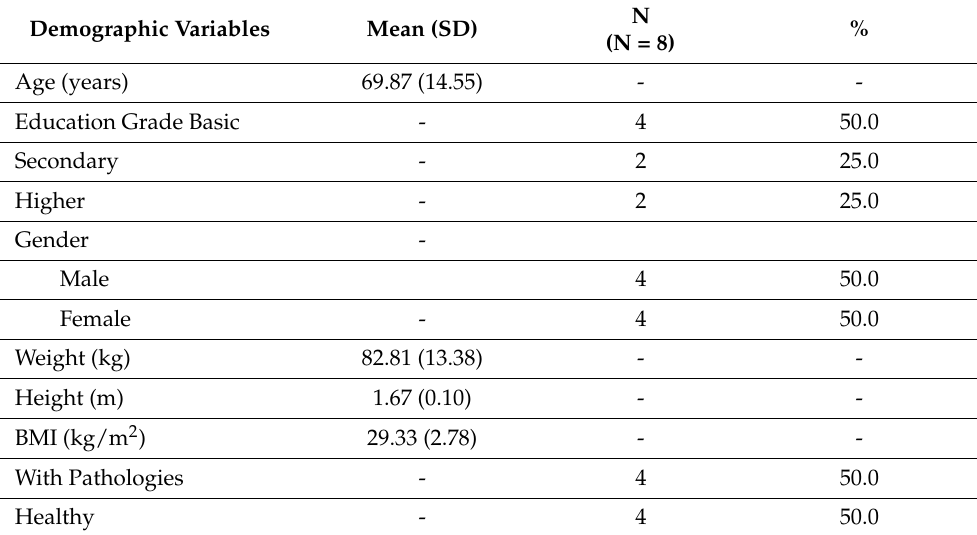
Table 1. Characterization of the Cognitive Interviews